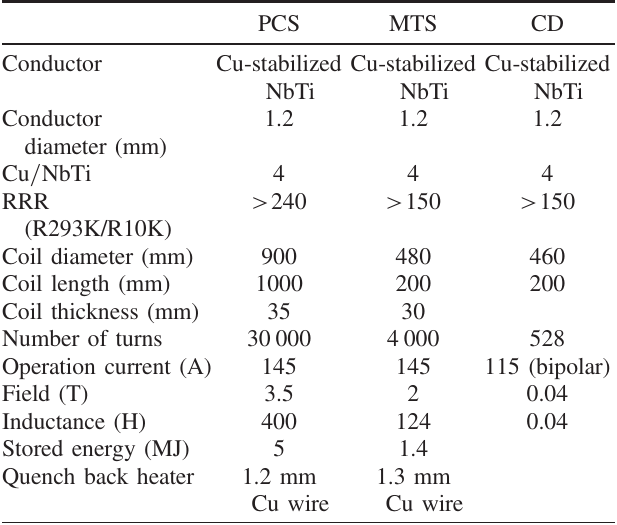
TABLE I. Design parameters of the PCS, MTS, and CD magnets. The coil thickness for the PCS is 40 mm upstream of 400 mm to increase the magnetic field. RRR is a residual- resistance ratio of superconductors